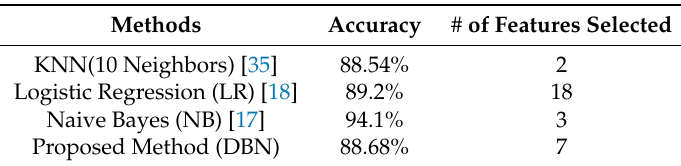
Table 9. Comparison with other model based